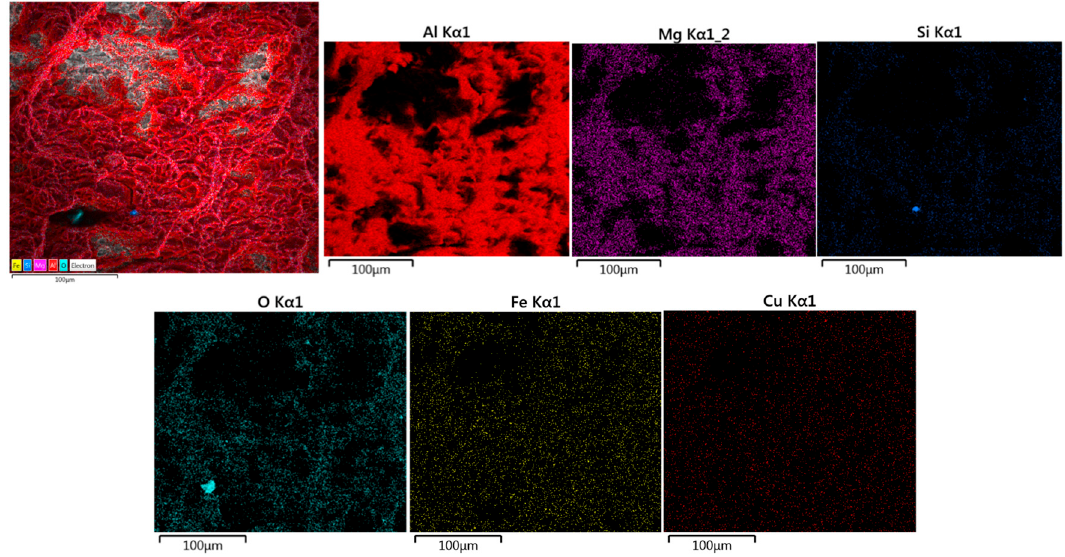
Figure 20. EDS analysis of cold-sprayed, stressed 25% fracture surface after B117 testing, showing the fracture surface is predominately free of precipitates or element segregation. Two second-phase particles are obvious, one an oxide inclusion and the other rich in Si.